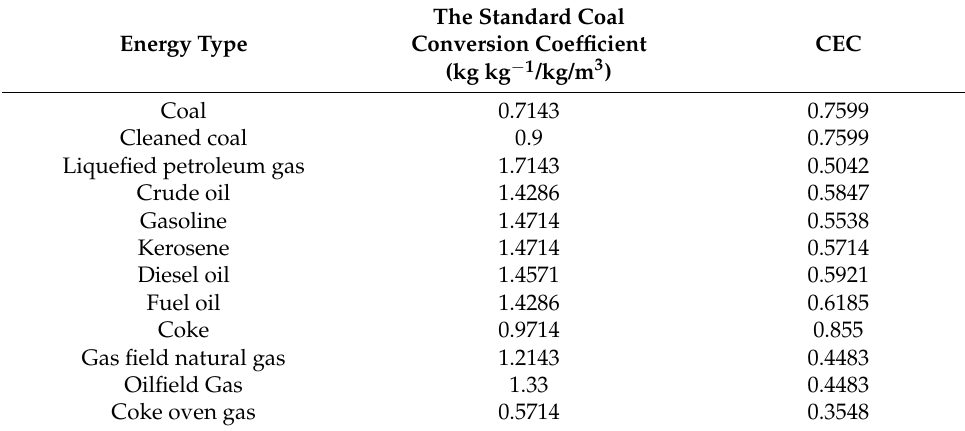
Table 1. CEC for each type of fossil